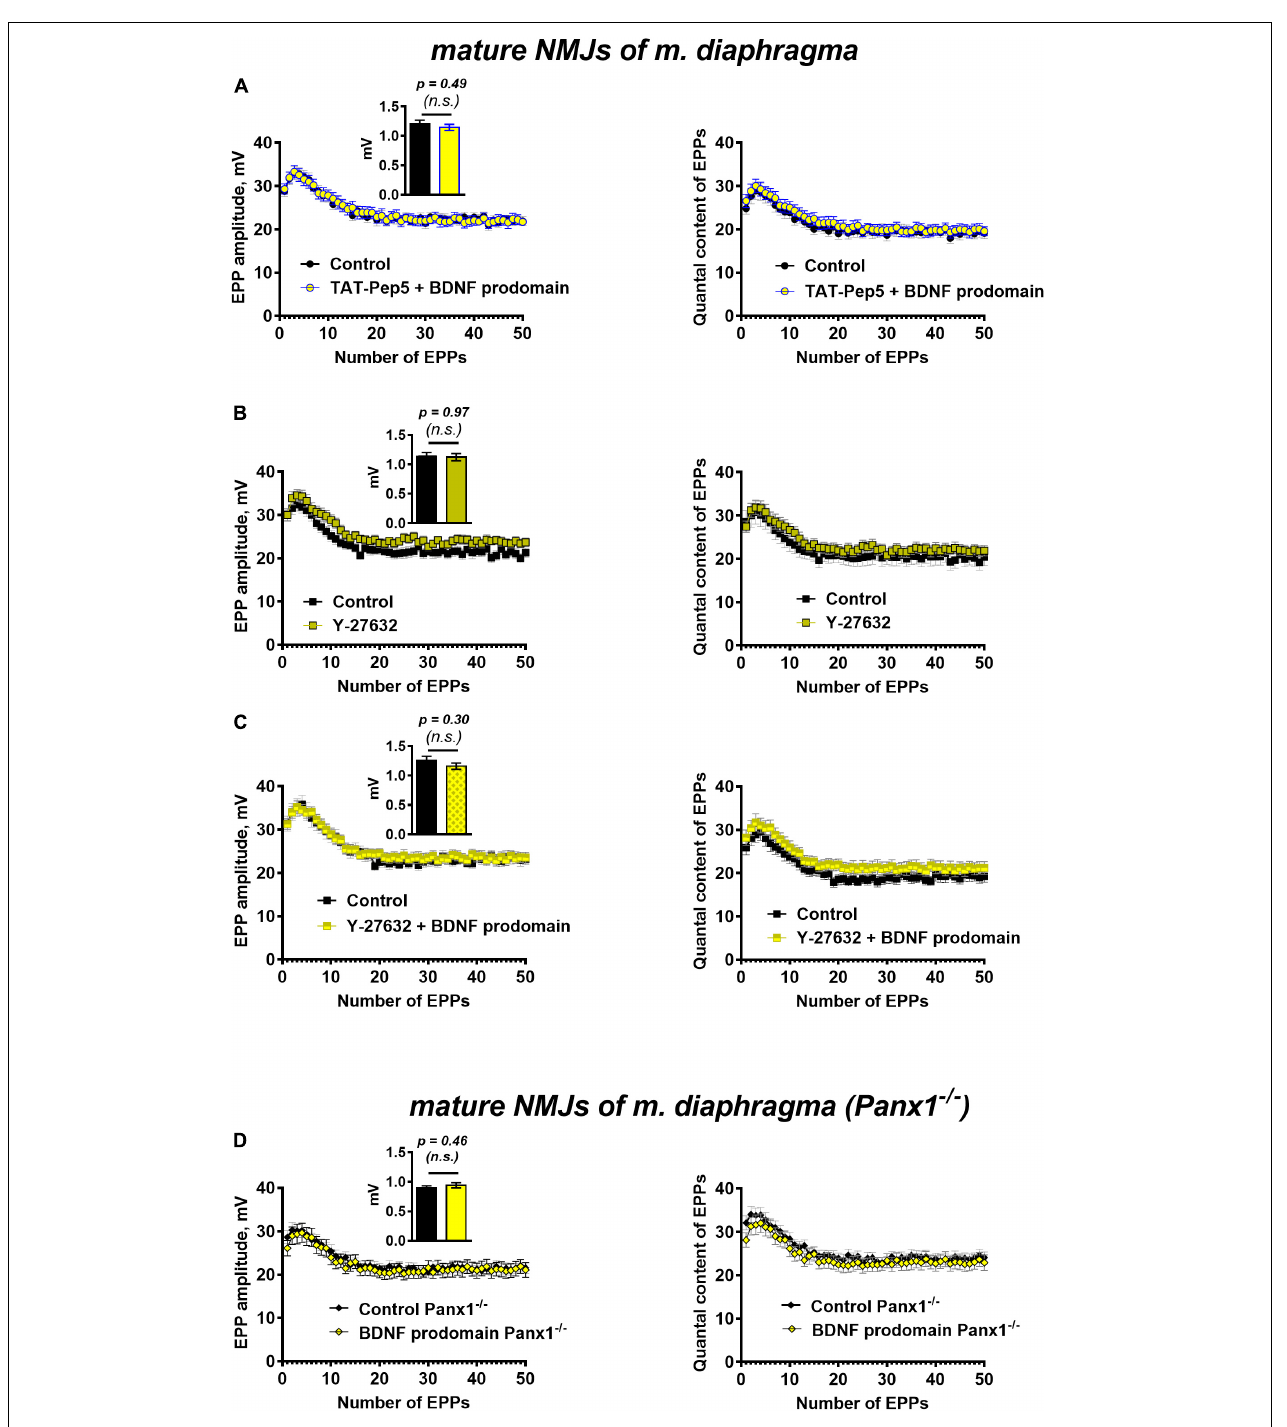
FIGURE 6 | p75 receptors and Rho-signaling pathway underlie BDNF prodomain-triggered inhibition of evoked ACh release at mature NMJs. Moreover, the inhibitory effect of the BDNF prodomain (1 nM) on the evoked neuromuscular transmission depends on the endogenous activity of synaptic purinoreceptors at mature NMJs. (A) Changes in the EPP amplitude (left) and in the quantal content of EPPs (right) in control ( n = 20) and upon BDNF prodomain (1 nM) in the presence of Rho-GDI-associated p75 signaling inhibitor TAT-Pep5 (1 µ M, n = 21). (B) Changes in the EPP amplitude (left) and in the quantal content of EPPs (right) in control ( n = 17) and in the presence of ROCK inhibitor Y-27632 (3 µ M, n = 21). (C) Changes in the EPP amplitude (left) and in the quantal content of EPPs (right) in control ( n = 15) and upon BDNF prodomain (1 nM) in the presence of Y-27632 ( n = 21). (D) Changes in the EPP amplitude (left) and in the quantal content of EPPs (right), registered from NMJs of Panx1 − / − mice in control ( n = 24) and in the presence of BDNF prodomain ( n = 22). Insets show MEPP amplitudes.